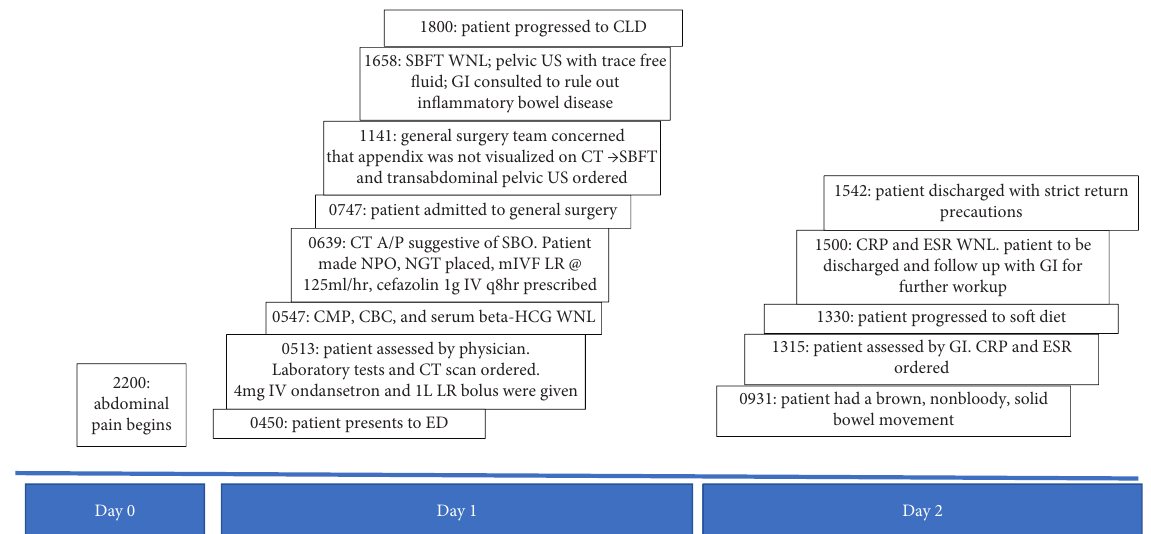
Figure 2: Timeline of symptom onset through hospital discharge. Day 0 represents symptom onset. Each event on timeline has time of occurrence listed in military time. SBFT, small bowel follow-through; WNL, within normal limits; US, ultrasound; GI, gastrointestinal; CT, computed tomography; A/P, abdomen and pelvis; SBO, small bowel obstruction; NPO, nil per os; NGT, nasogastric tube; mIVF, maintenance intravenous fluids; LR, lactated ringers solution; CMP, comprehensive metabolic panel; CBC, complete blood count; beta- HCG, human chorionic gonadotropin; ED, emergency department; CLD, clear liquid diet; CRP, C-reactive protein; ESR, erythrocyte sedimentation